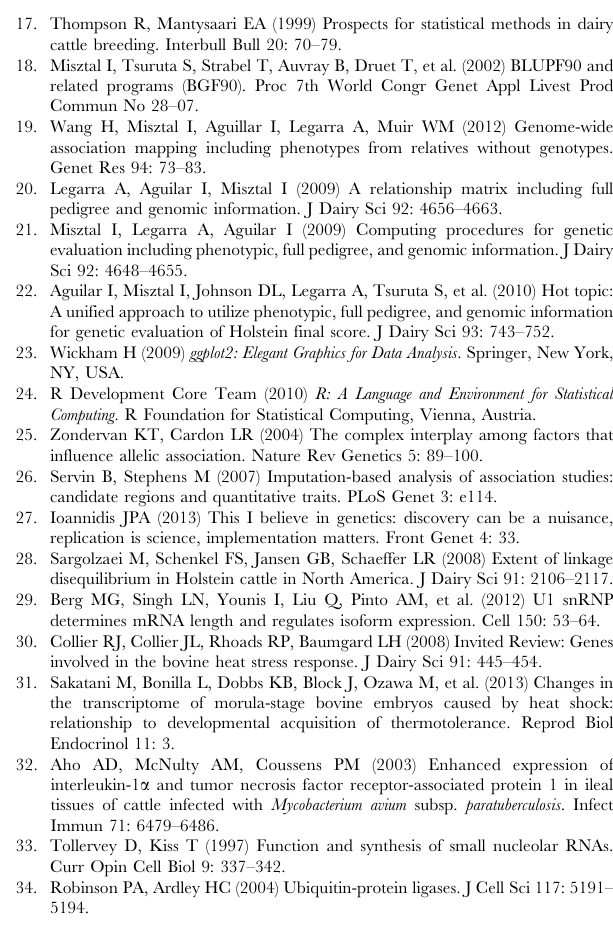
Table S3 The 20 loci with the largest proportion of SNP variance explained for rectal temperature using 4-SNP sliding windows. (PDF) Table S4 The 20 loci with the largest proportion of SNP variance explained for rectal temperature using 10-SNP sliding